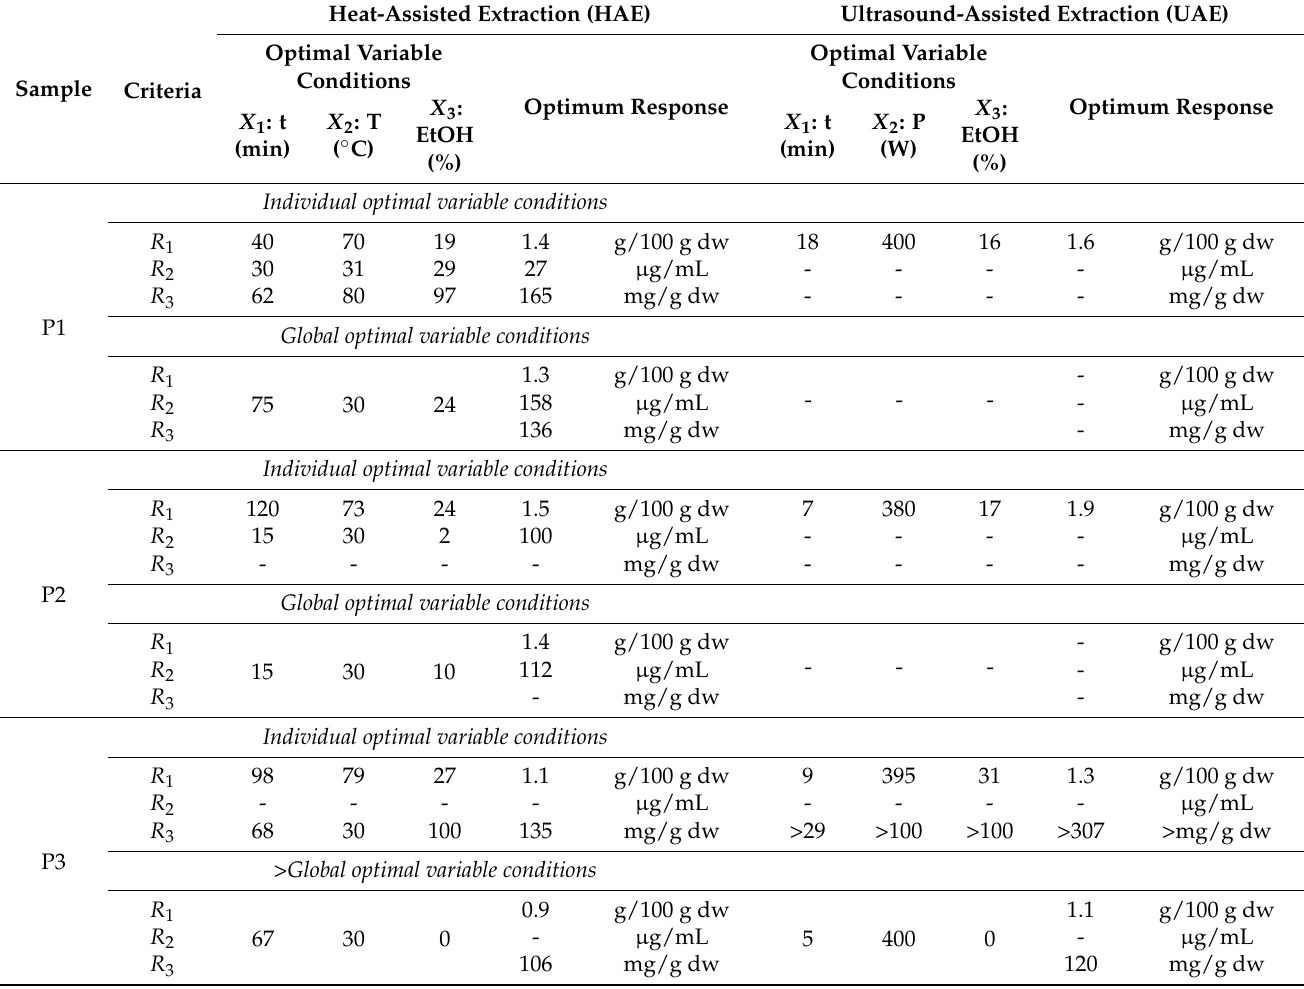
Table 4. Optimized conditions of the independent variables, presented as real values, with which the optimal values for the individual and global responses were